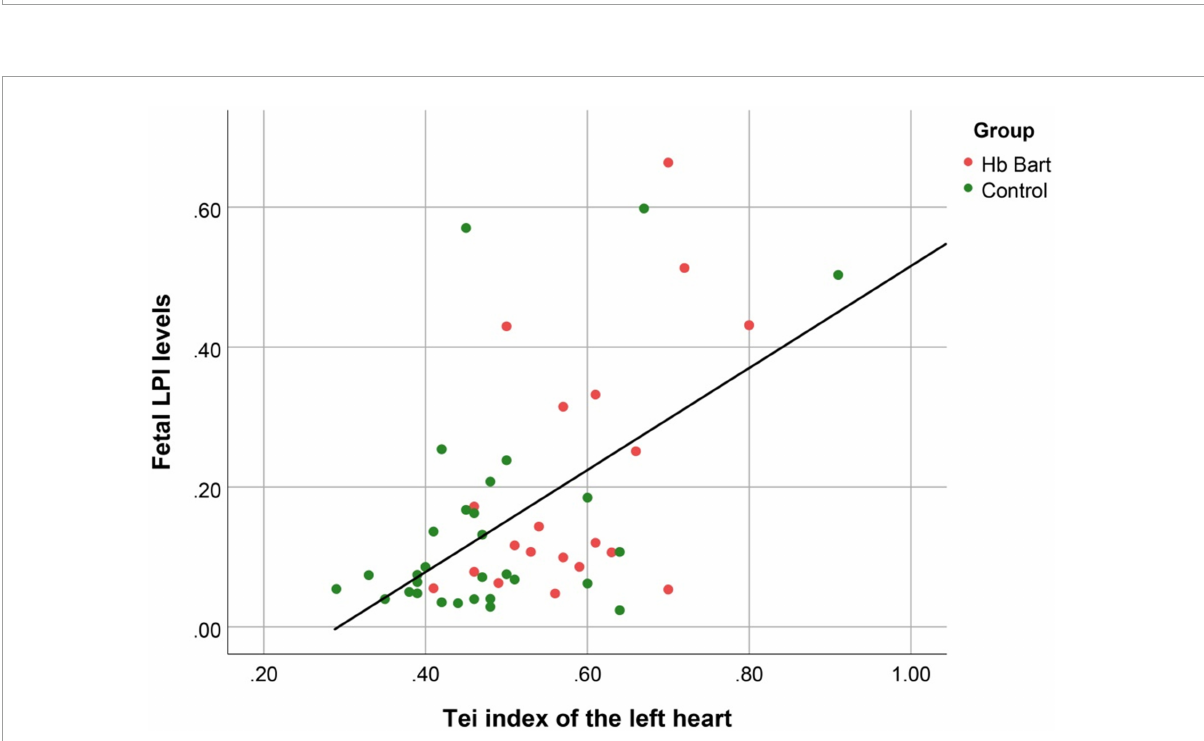
FIGURE4 The correlation between fetal LPI (Labile Plasma Iron) levels and fetal left myocardial performance index (Tei) (Linear function; R 2 : 0.291; p <